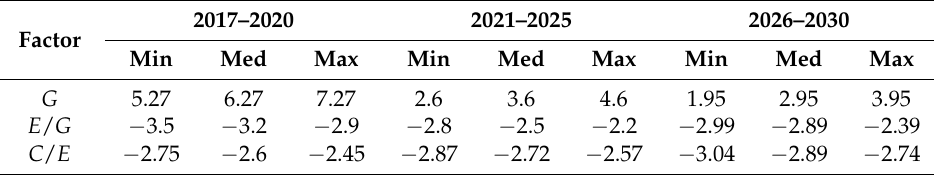
Table 4. Annual rate of change in each factor for the low-carbon scenario. Unit: %. Factor